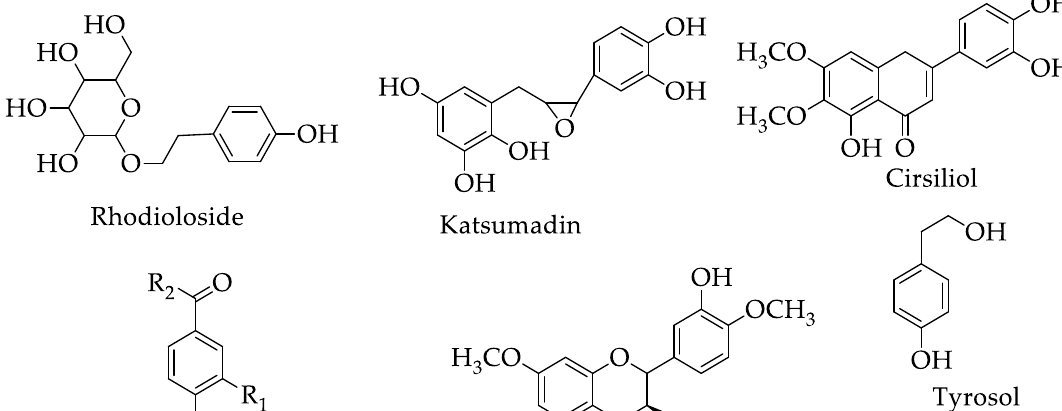
Figure 6. Chemical structures of H. abyssinica characterized using gas chromatography coupled with mass spectrometry (GC-MS) analysis.